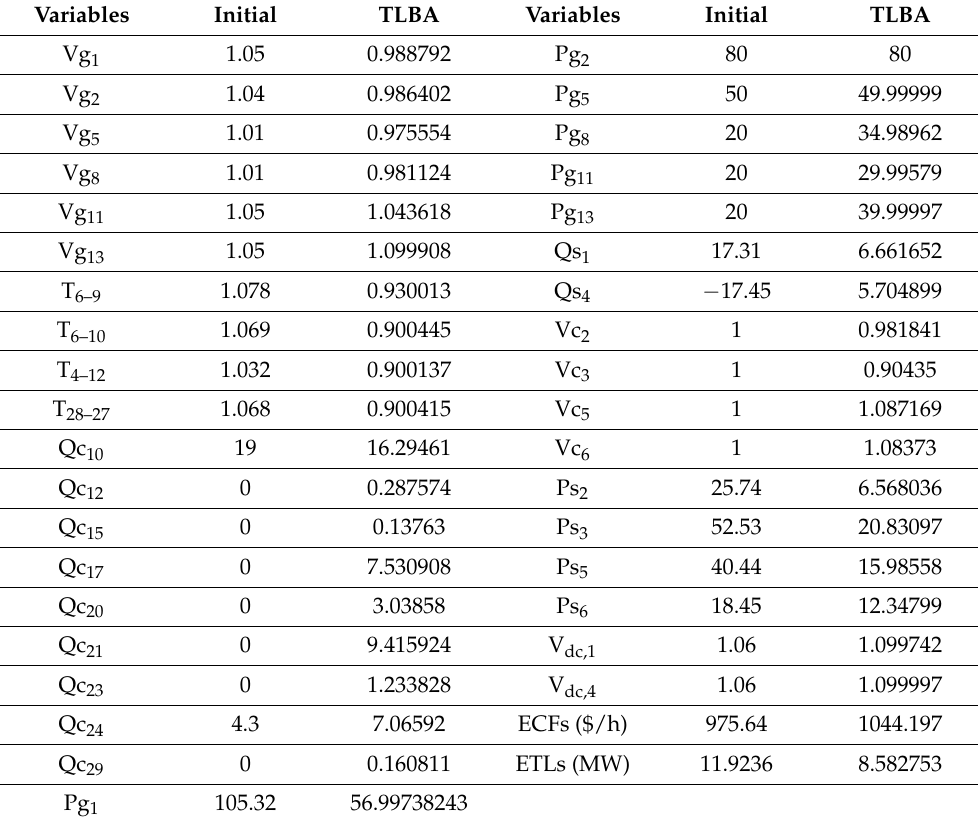
Table 4. Simulation results of TLBA for the minimization of the ETLs of the IEEE 30-bus